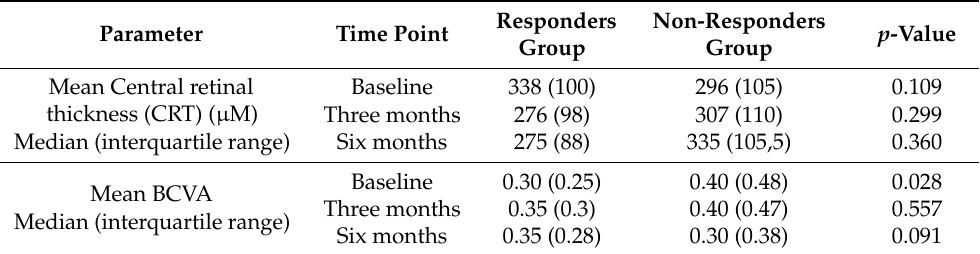
Table 6. Central retinal thickness (CRT)r and BCVA comparison between the responder and non- responder groups.